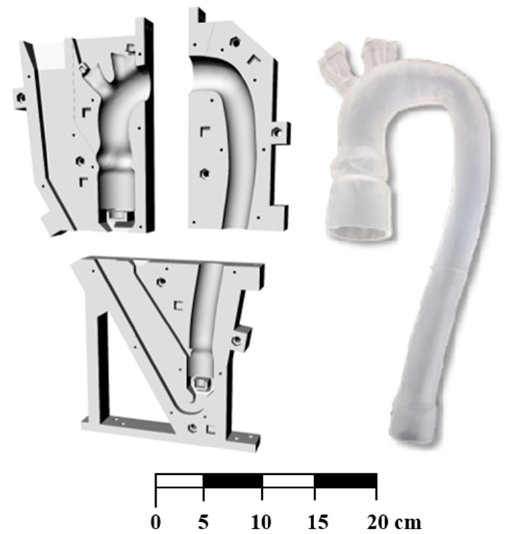
Figure 1. The customized mold to realize the silicone aorta. The mold is divided into six modules.